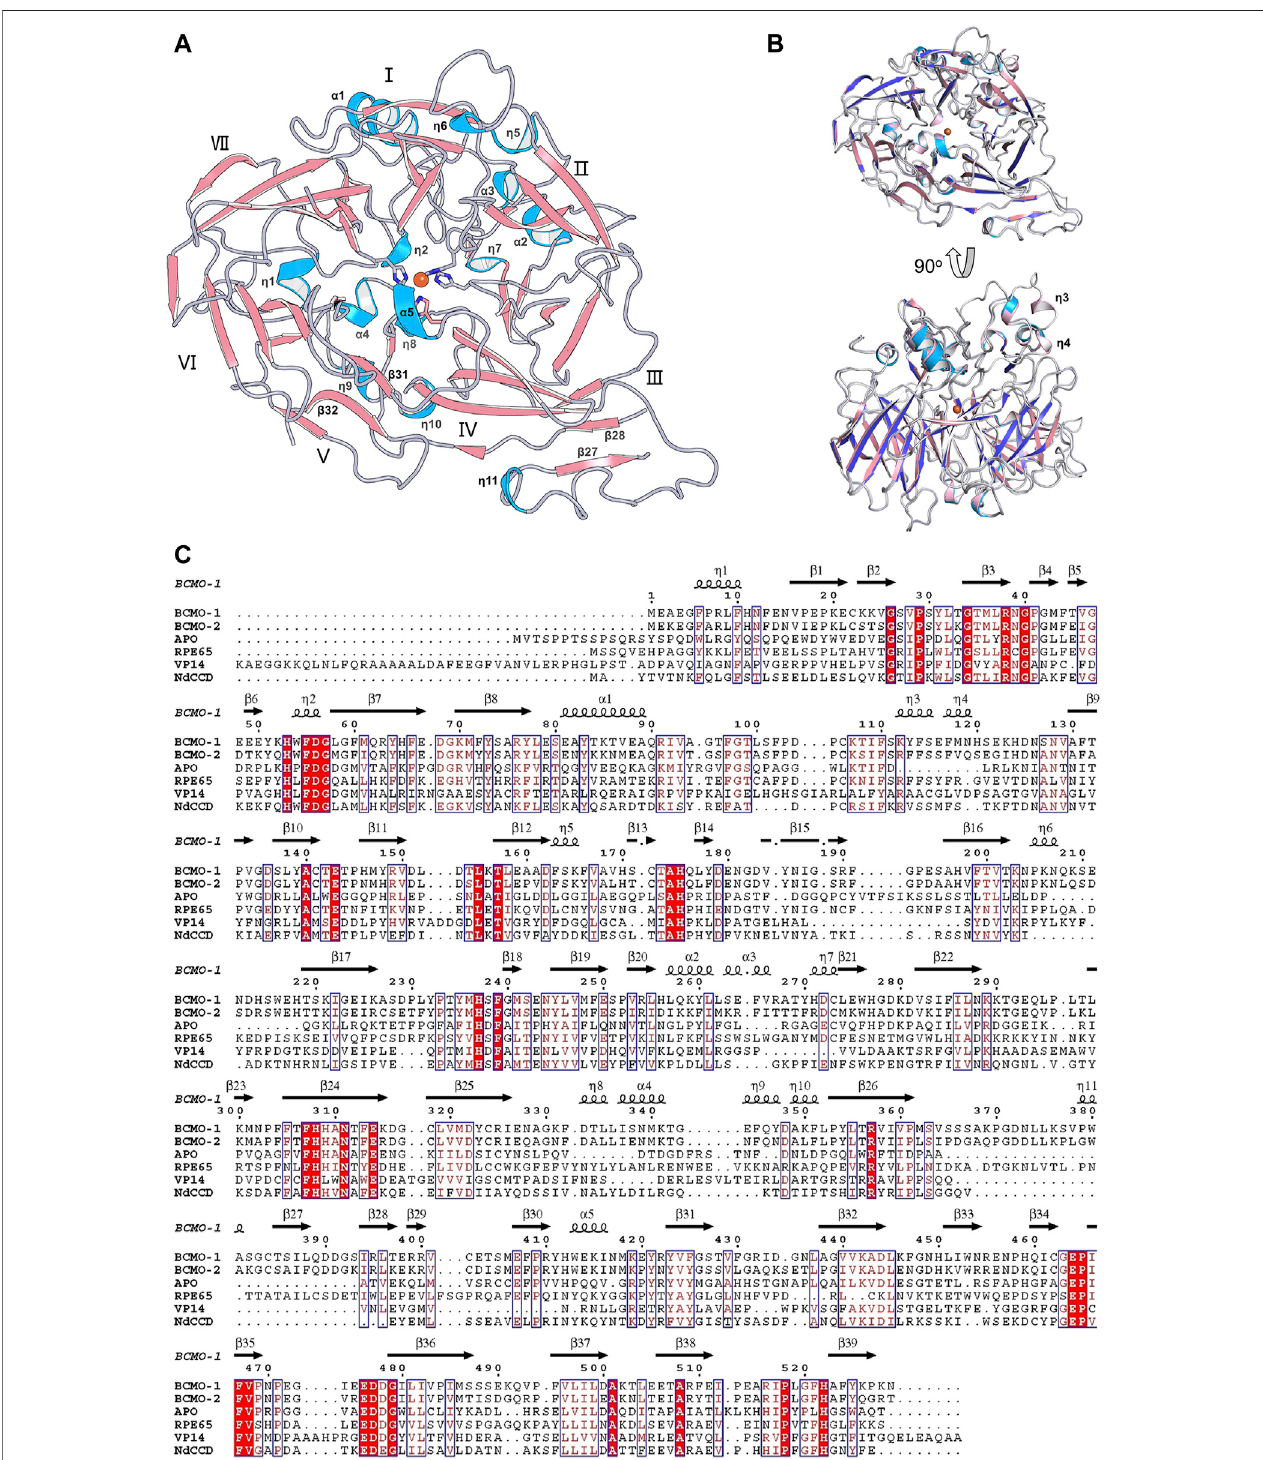
FIGURE 4 | Overall structure of BCMO-2 and comparison with BCMO-1. (A) Secondary structural elements of BCMO-2. α -Helices and η -helices are in light blue and arelabeled; β -strands areinlightred. β -Strands27,28,31,and32arelabeled. (B) SuperimpositionofBCMO-1andBCMO-2.BCMO-1iscoloredasin Figure2 η - Helices 3 and 4 that are not observed in BCMO-2 are labeled. (C) Amino acid sequence alignment of BCMO-1, BCMO-2, ACO, RPE65, VP14, and NdCCD. The alignment fi gure was created by ESPript. Conserved residues are in red background, and similar residues are in red and boxed. Secondary structural elements of BCMO-1 are shown on the top of the